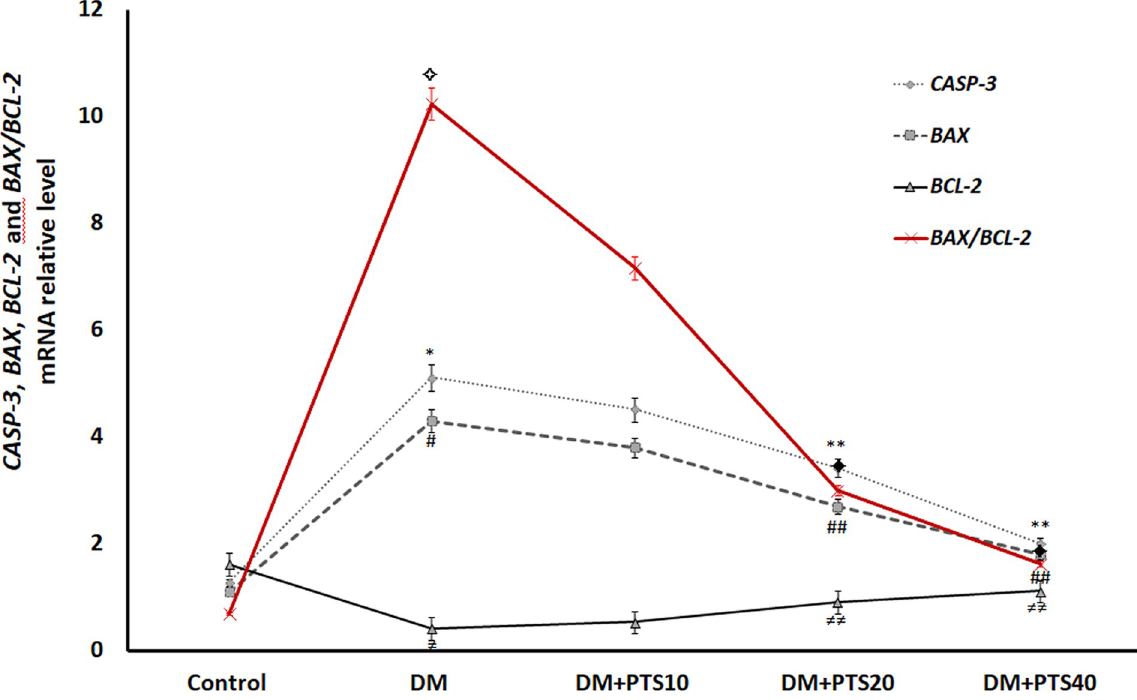
Fig 5. Effect of PTS on CASP-3 , BAX , BCL-2 and BAX/BCL-2 gene expressions in the rat groups after STZ-application to end of the experimental period. � , ✧ , #, 6¼ , significantly different from Control and treatment rat groups (P < 0.001 for all); �� , ✦ , ##, 6¼6¼ significantly different from DM+PTS10 (P < 0.05 for